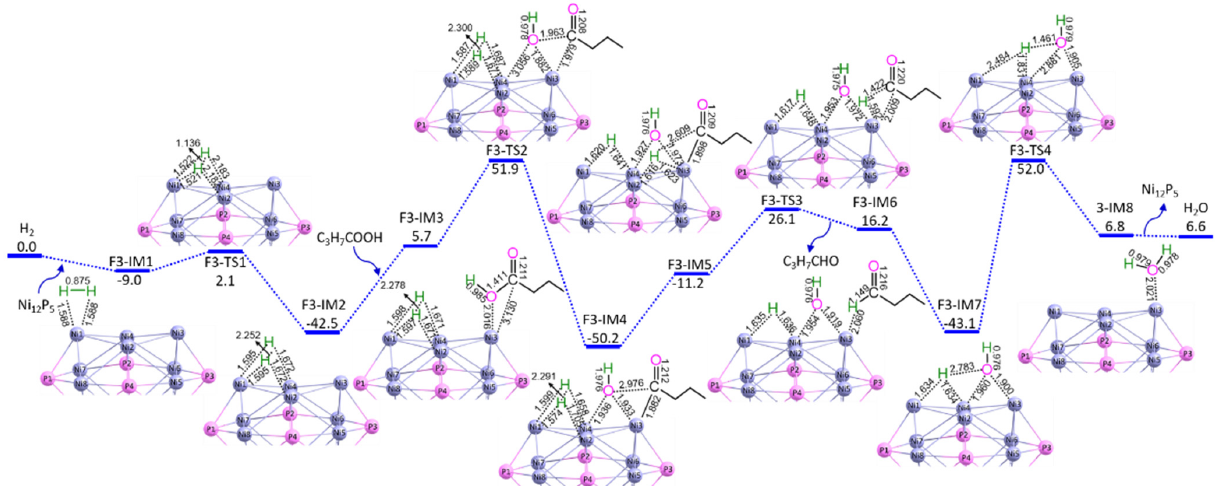
Figure 3. The potential energy curves with the relative Gibbs free energy ( G r , kJ mol − 1 ) and the geo- metric structures with bond lengths (Å) for reaction stage S3 over Ni 12 P 5 cluster at GGA − PBE/DSPP, DNP level. For brevity, some hydrogen atoms are hidden.